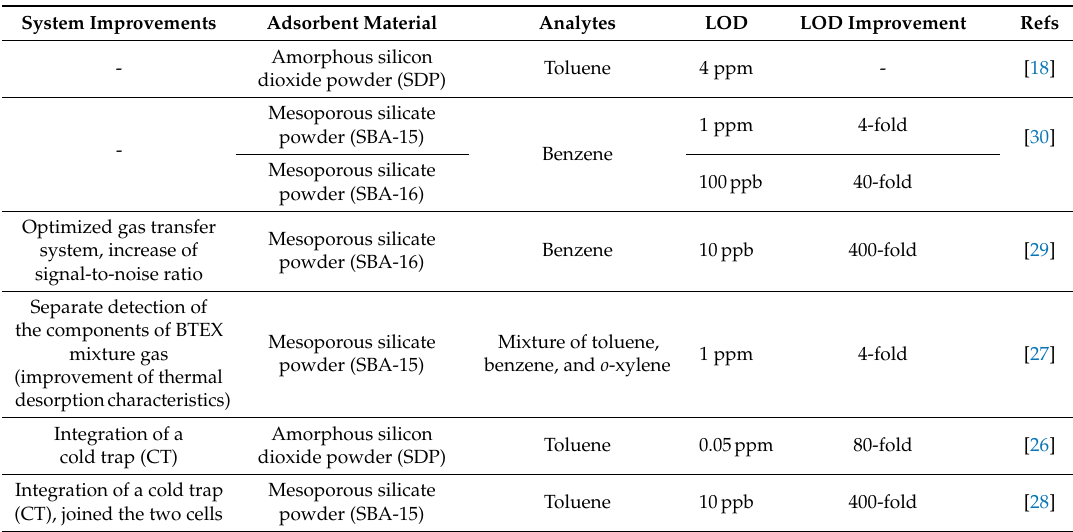
Table 3. Architectures developed to improve the performance of the concentration and detection cell system by Ueno et